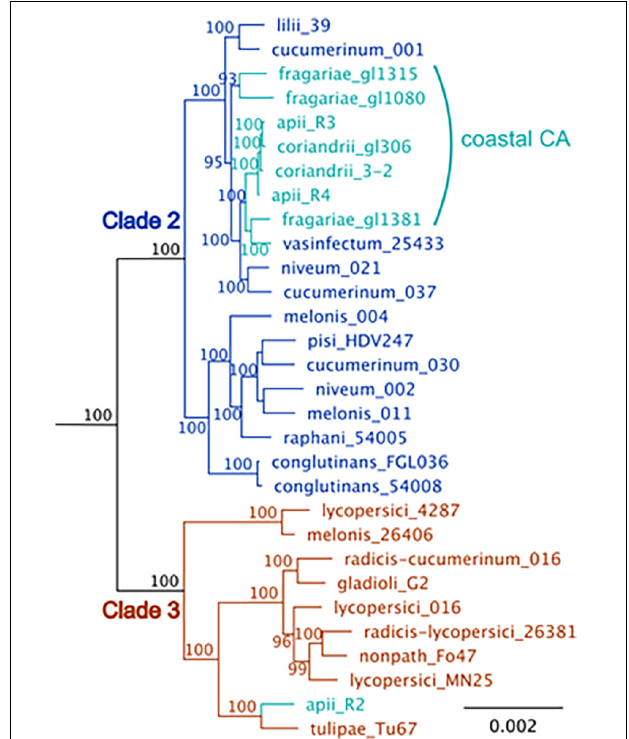
FIGURE 3 | A maximum-likelihood phylogenetic tree of F. oxysporum isolates that cause disease in celery (apii), strawberry (fragariae), and coriander (coriandrii) in comparison to selected assemblies of F. oxysporum from NCBI. The figure is modified from Henry et al. (2020) with the addition of three F. oxysporum f. sp. fragariae sequences from Henry et al. (2021). BUSCO v. 2.0 (Benchmark of Unique Single Copy Orthologs) was used to identify 2,718 full-length, single-copy genes that were in all strains; these genes are primarily in the core genome. Sequences were aligned with MUSCLE and concatenated into a single ∼ 5.5 Mbp sequence. The tree was generated with RaxML with the general time-reversible evolutionary model, rooted with F. oxysporum f. sp. cubense tropical race 4, which is in Fusarium oxysporum species complex (FOSC) clade 1. Support for the tree is based on 1000 bootstrap replicates; bootstrap values below 70 are not shown. The coastal California isolates are shown in turquoise. F. oxysporum f. sp. apii race 2 (apii_R2), is in FOSC clade 3. The other F. oxysporum f. sp. apii (apii, R3, race 3) and (apii race 4, apii_R4) are in FOSC clade